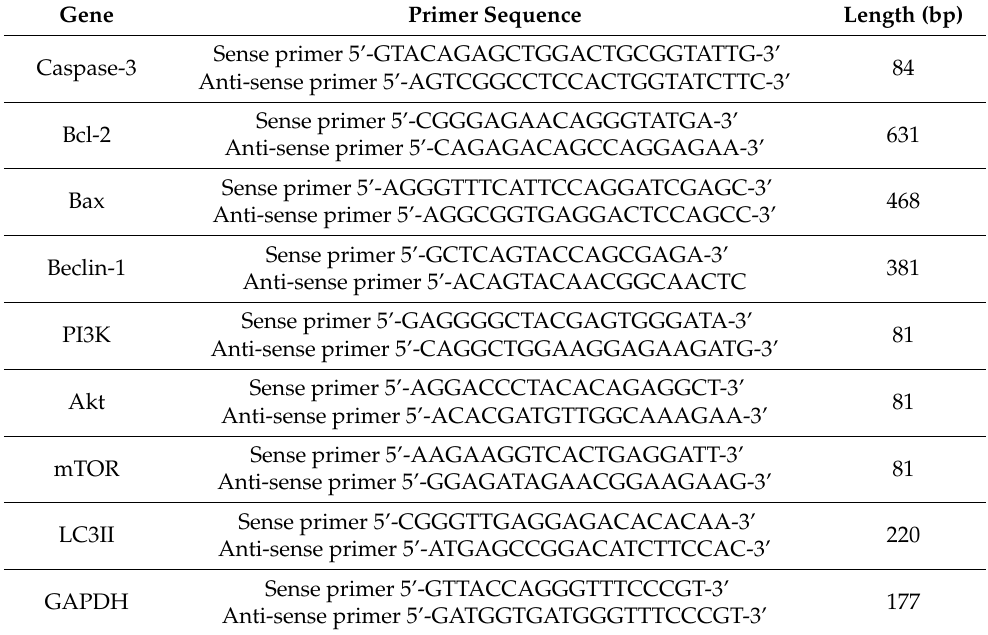
Table 1. Gene primer